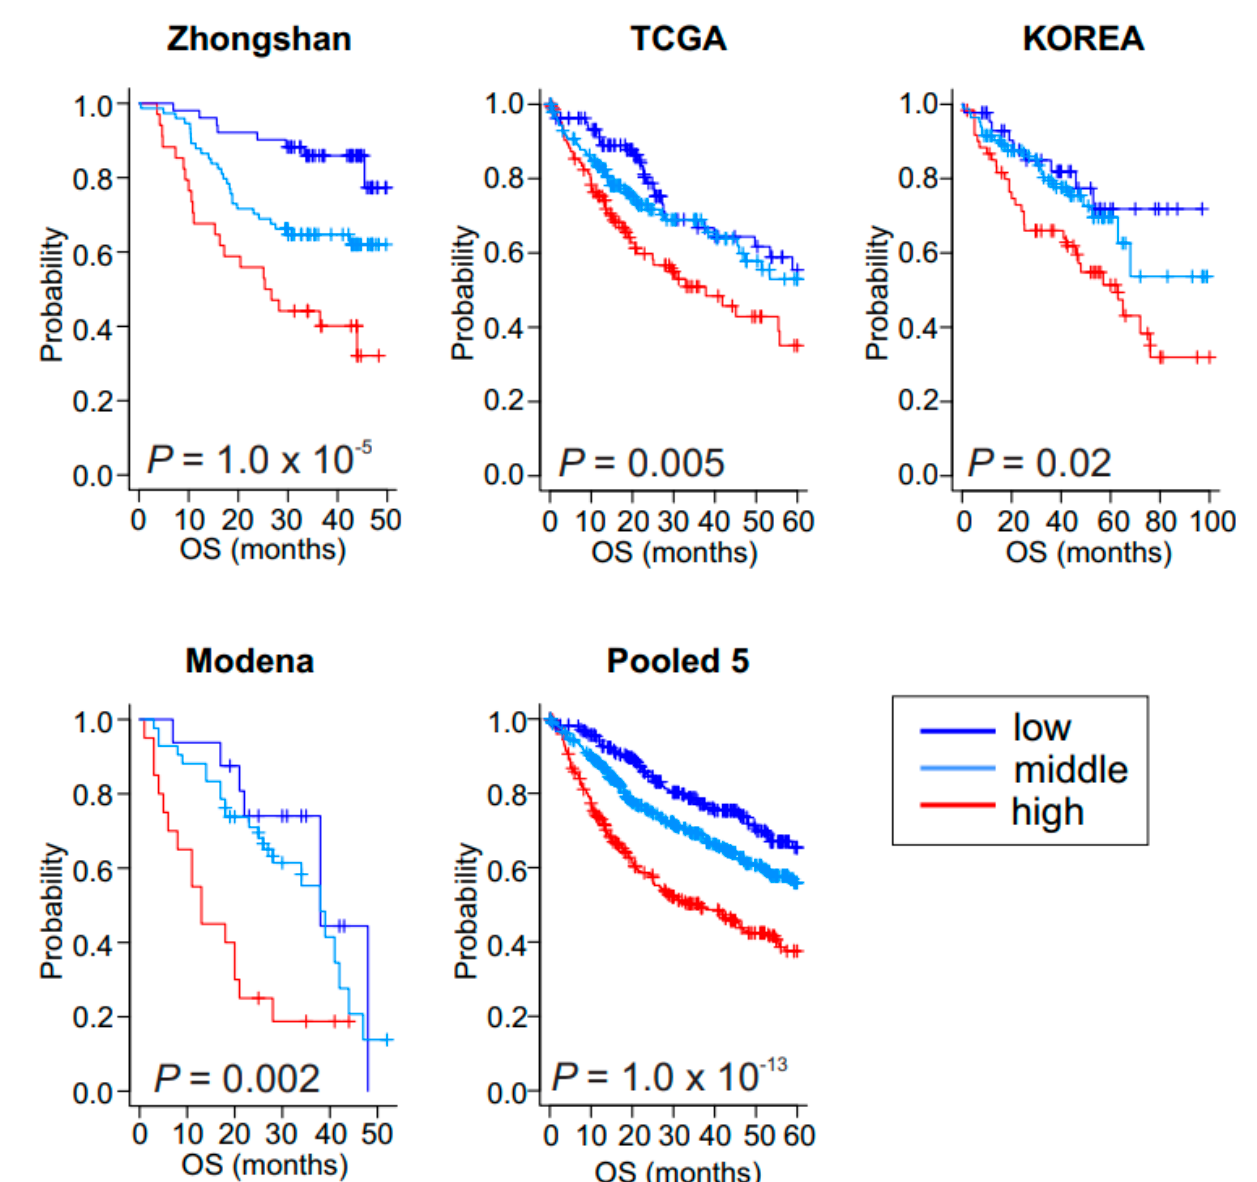
Figure 3. Validation of clinical association of low, middle, and high glycolysis metabolic subtypes in hepatocellular carcinoma. Kaplan–Meier plots of overall survival (OS) in patients in the validation cohorts. Zhongshan cohort ( n = 159), Korea cohort ( n = 188), The Cancer Genome Atlas (TCGA) cohort ( n = 371), Modena cohort ( n = 78), and pool of five cohorts ( n = 1038).